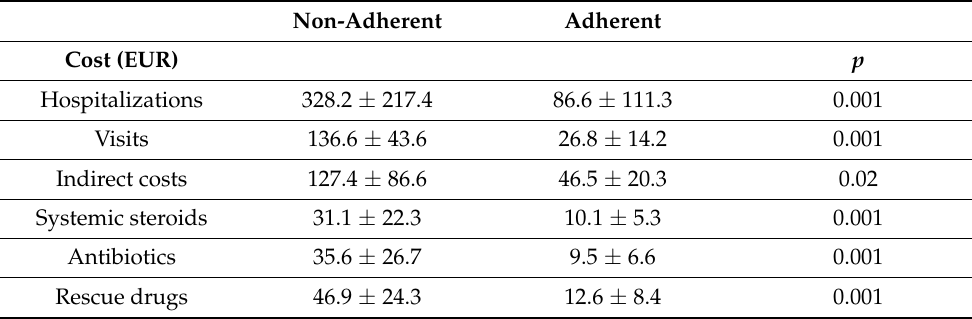
Table 3. Components of mean cost (means ± SD) over twelve months in non-adherent and adherent adolescents, and corresponding statistical comparisons. (Cost of prescribed regular daily treatment not